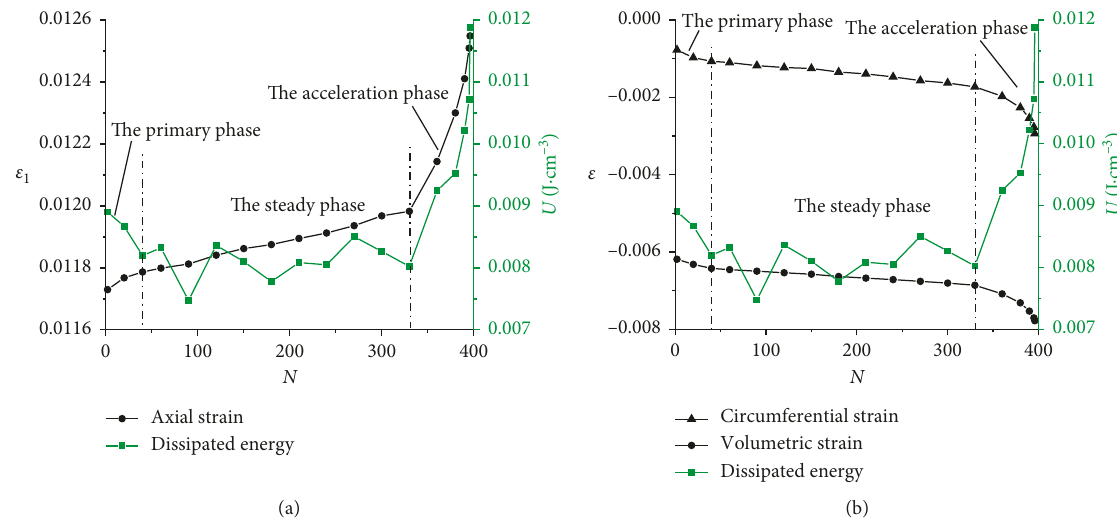
Figure 12: Comparison of the three phases of strain and dissipated energy evolution: (a) axial strain and dissipated energy and (b) circumferential strain, volumetric strain, and dissipated